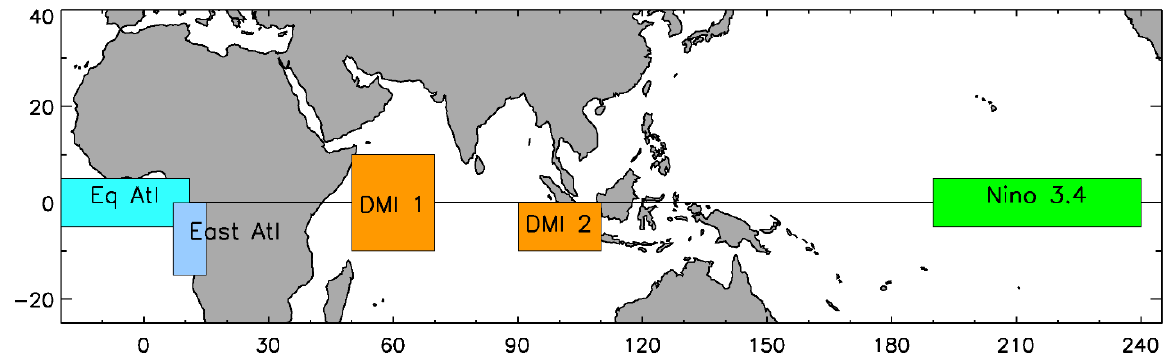
Figure 2. Ocean sectors used for calculating the Dipole Mode Index (DMI), Niño 3.4, equatorial Atlantic and eastern Atlantic SST time series.